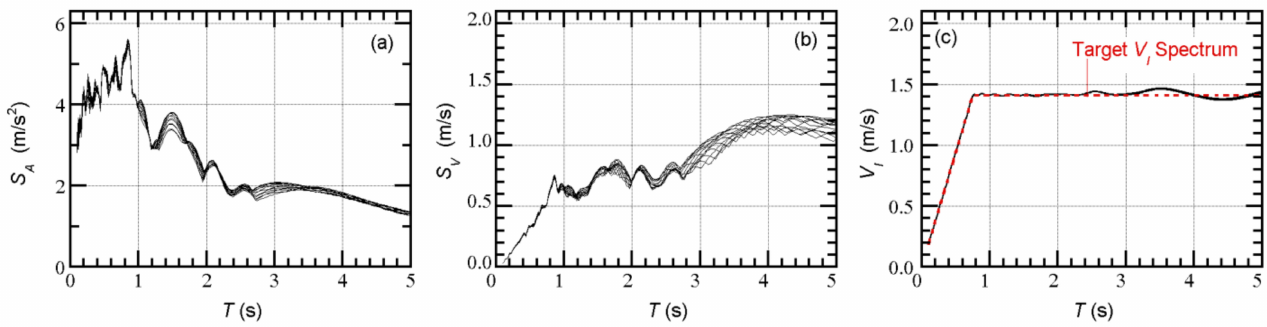
Figure 16. Horizontal response spectra of the artificial ground motion (Art-2 series): ( a ) Elastic acceleration response spectrum (damping ratio: 0.05); ( b ) elastic velocity response spectrum (damping ratio: 0.05); ( c ) elastic total input energy spectrum (damping ratio: 0.10).